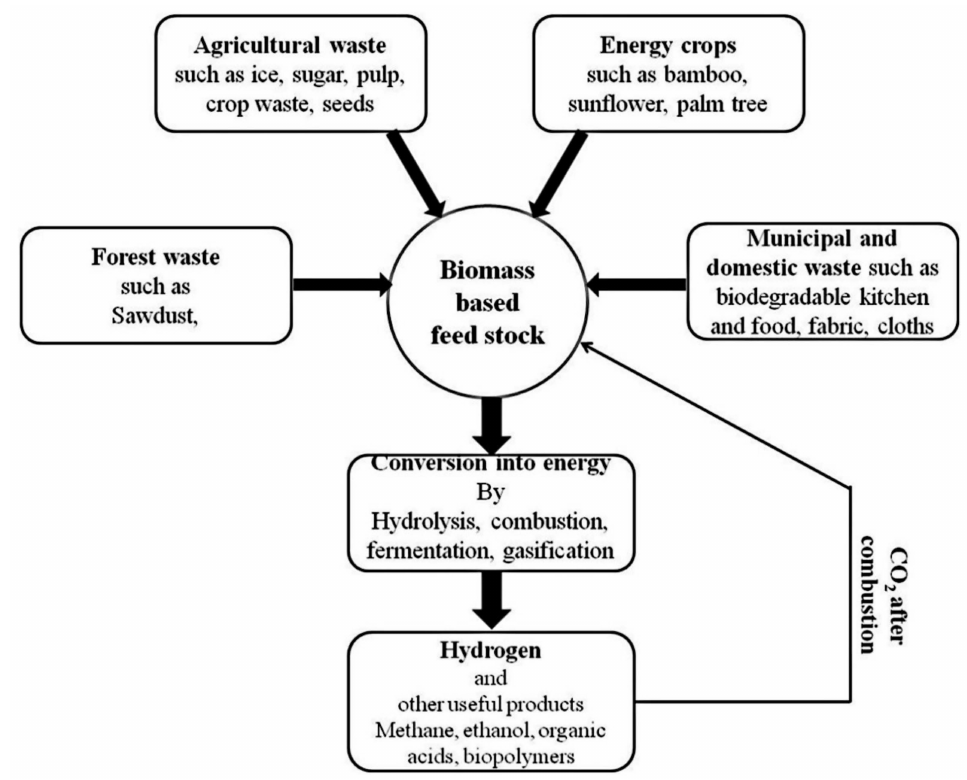
Figure 6. Sources of biomass and their conversion into hydrogen and other beneficial products [72]. Reproduced with permission from Elsevier,